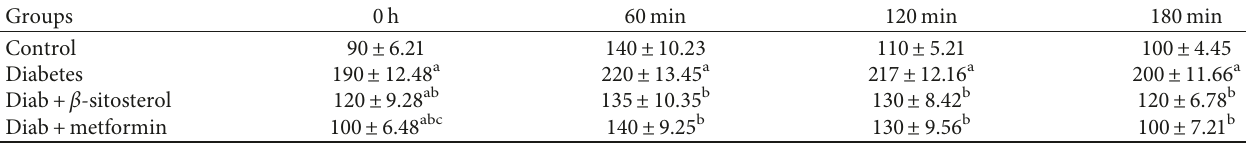
Table 2: Oral glucose tolerance test in control, HFD, and sucrose-induced diabetic adult male rats. Groups